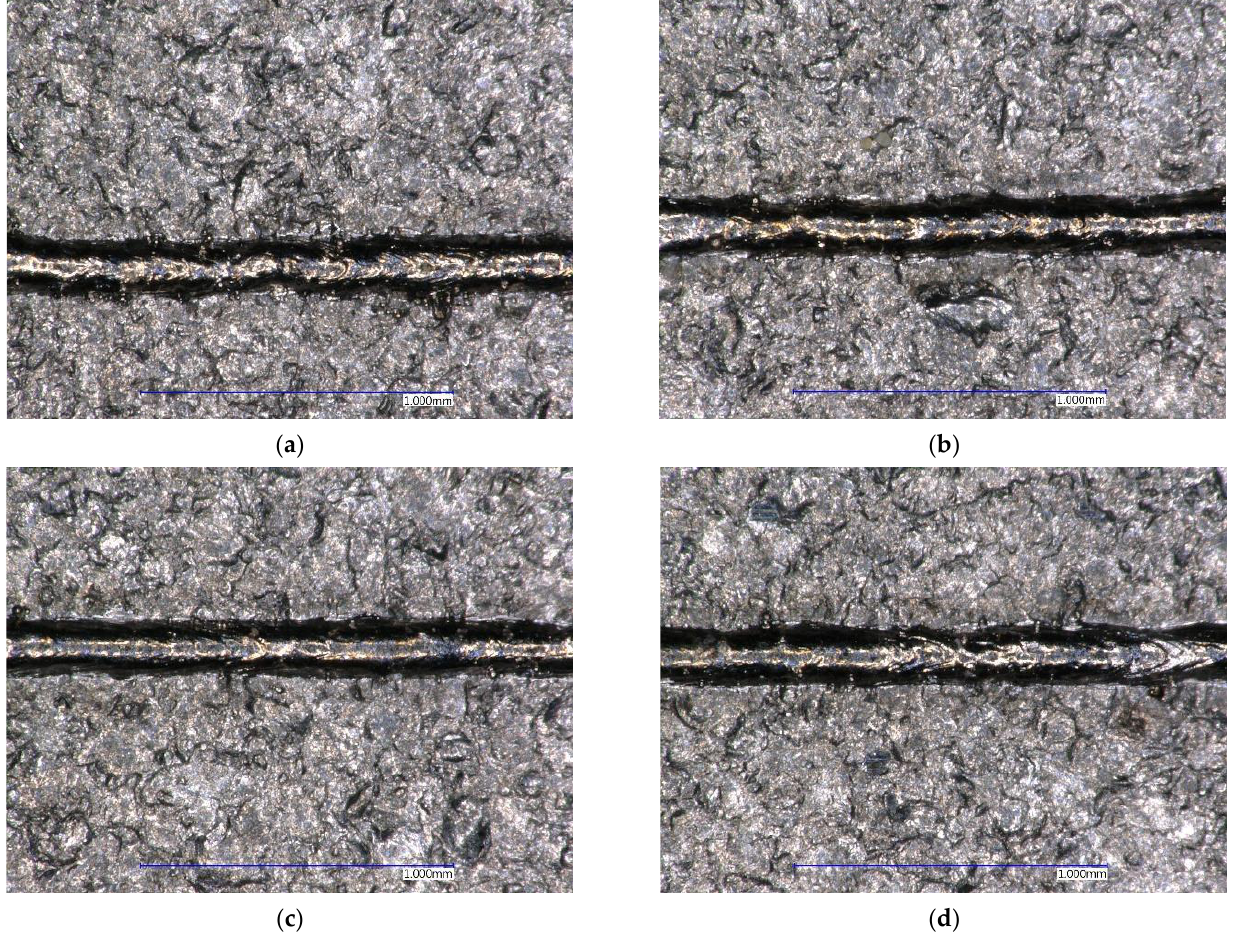
Figure 9. Visually suitable single tracks ( a ) P = 225 W, v = 200 mm/s; ( b ) P = 250 W, v = 200 mm/s; ( c ) P = 275 W, v = 250 mm/s; ( d ) P = 300 W, v = 250 mm/s.